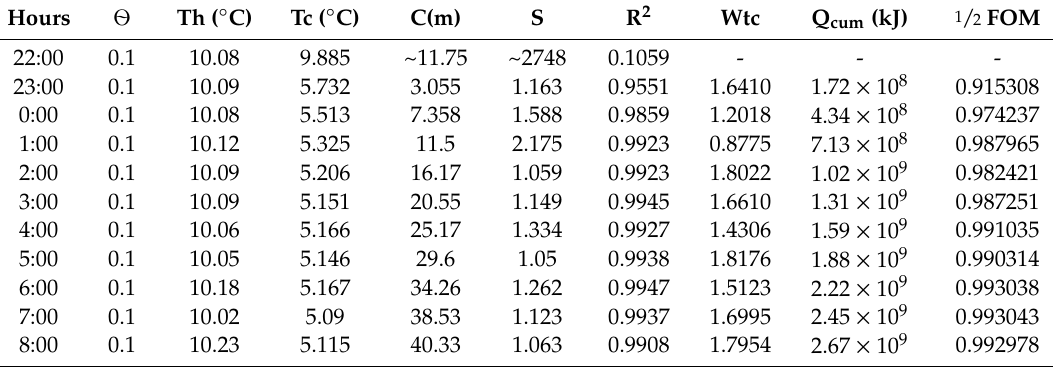
Table A2. 2nd–3rd January 2019 Curve Fitting and Performance Parameter analysis.